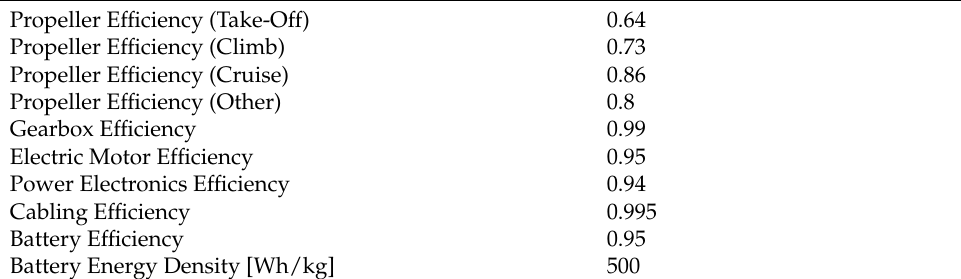
Figure 5. Propulsion system configuration. Table 3. Propulsion system